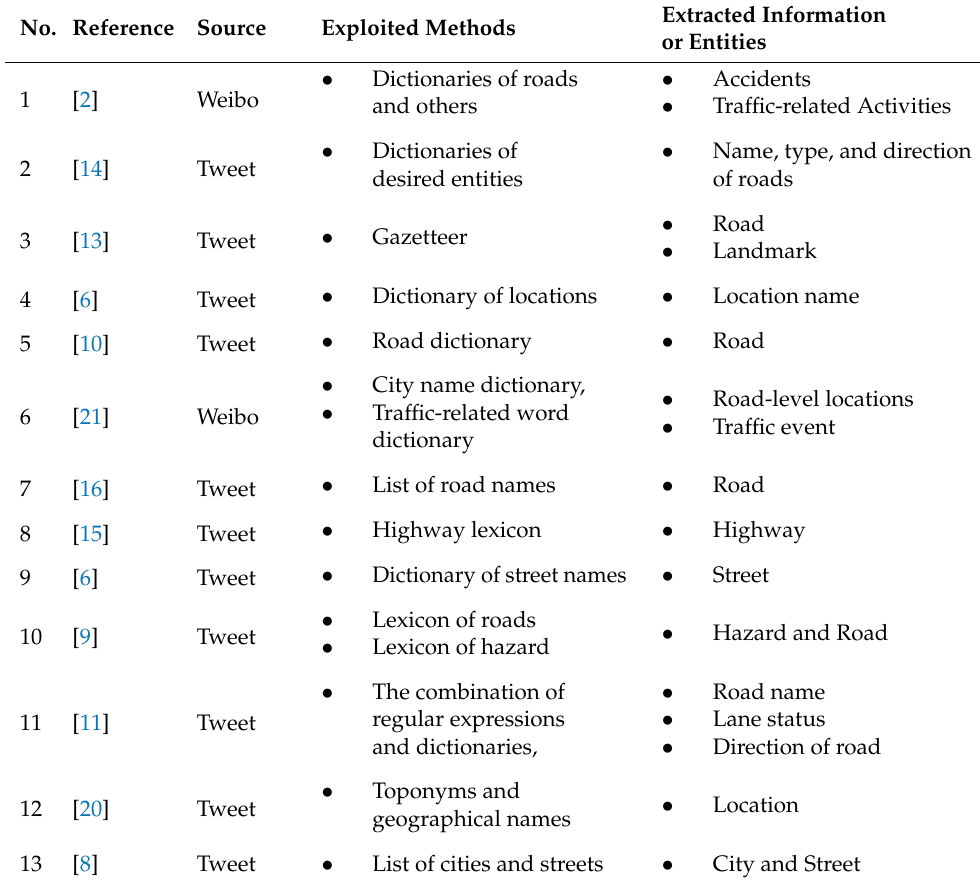
Table 1. Lexicon-based information extraction method adopted by existing